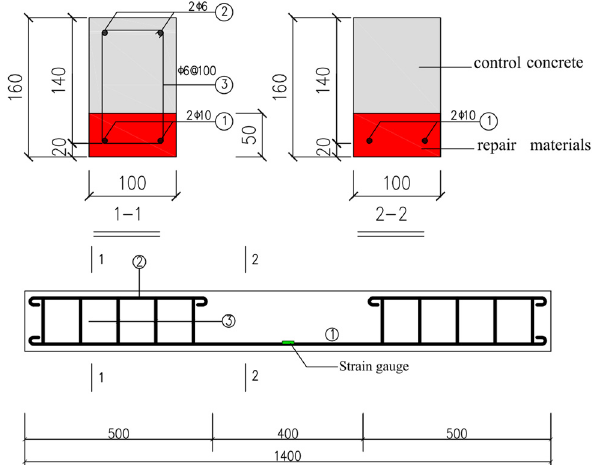
Figure 2: Dimensions and reinforcement of the reinforced concrete